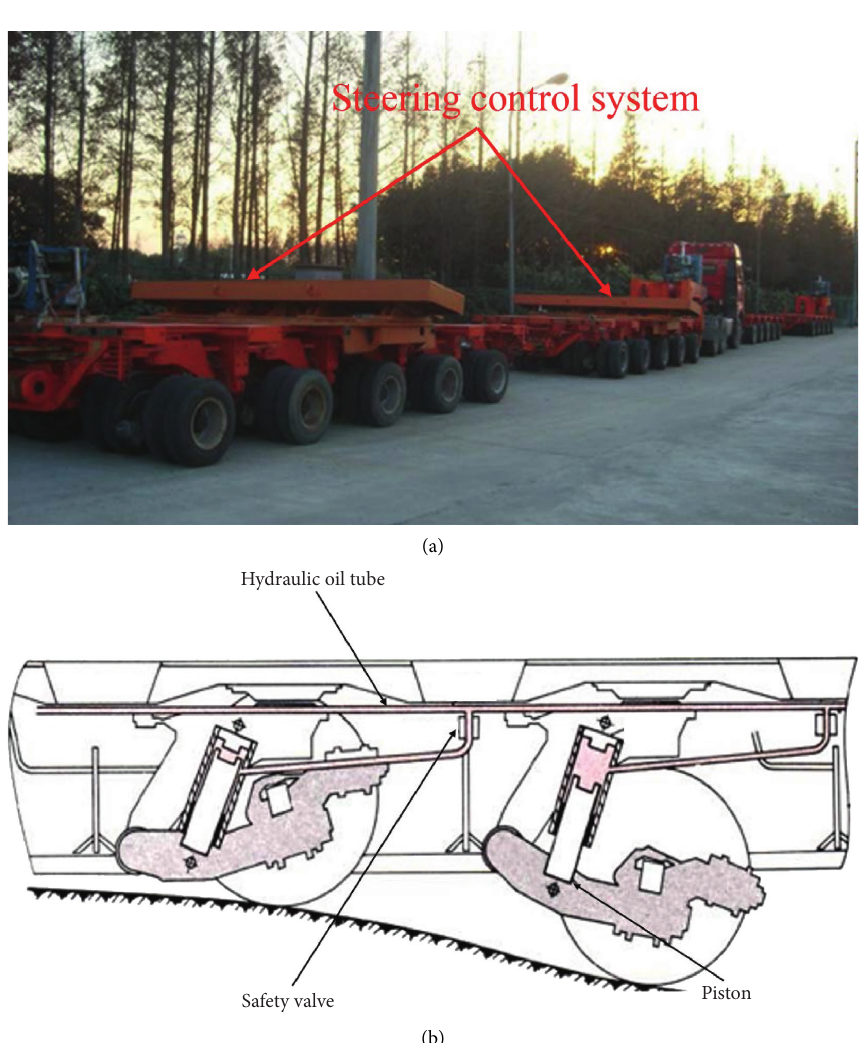
Figure 9: Special design of transportation: (a) the steering system; (b) automatic vertical balancing device.